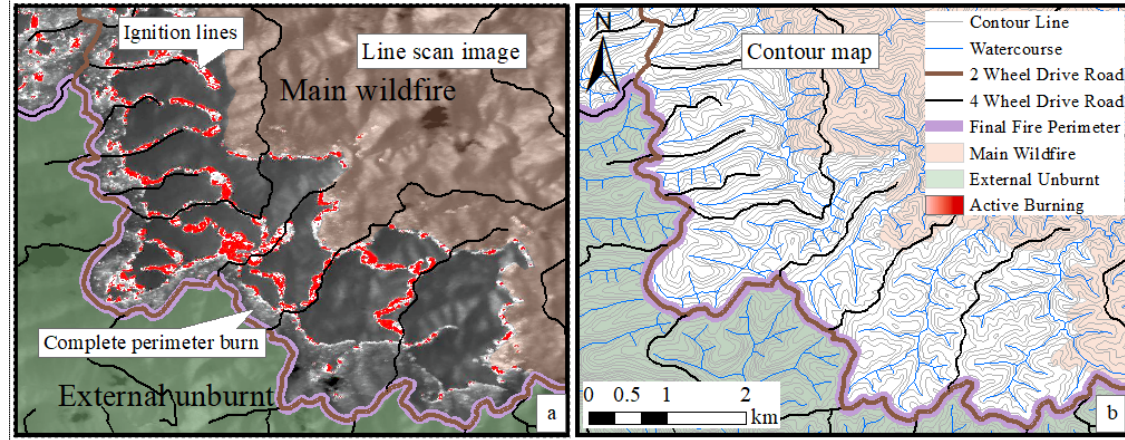
Figure 5. ( a ) A burnout in-progress is captured in a line scan image that has been overlaid with GIS layers of the final fire perimeter, roads, and burn areas (see legend). A backburn was completed along the road to form the final fire perimeter. This ~1000-ha burnout encompasses the area of unburnt (greyscale) fuel and active fire (red) intervening the backburn and main fire, east of the brown two-wheel-drive road. ( b ) The ignition pattern of this burnout followed the existing road network and terrain features visible with the contour map. The aim was for the intervening fuel to burnout in a controlled manner with a low intensity backing fire burning downhill from the ridgelines.